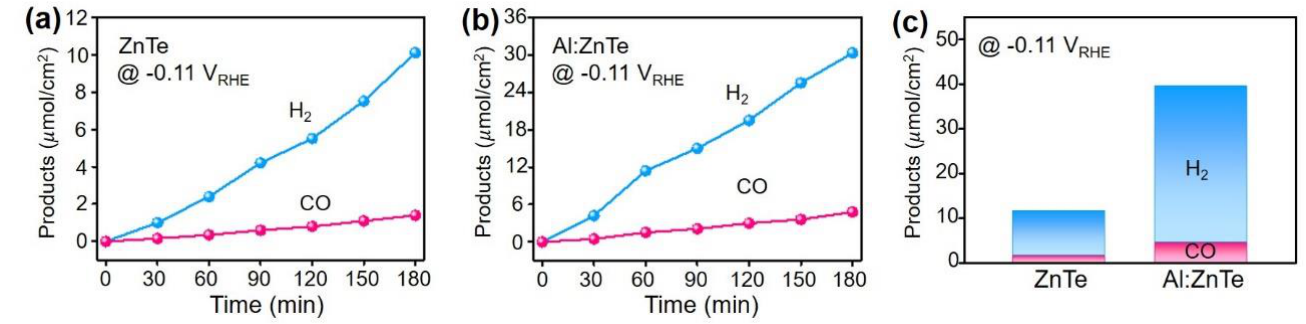
Figure 4. Time profiled products (H 2 and CO) distribution using ( a ) ZnTe and ( b ) Al:ZnTe. ( c ) Com- parison plot for accumulated products at − 0.11 V RHE measured for 3 h.